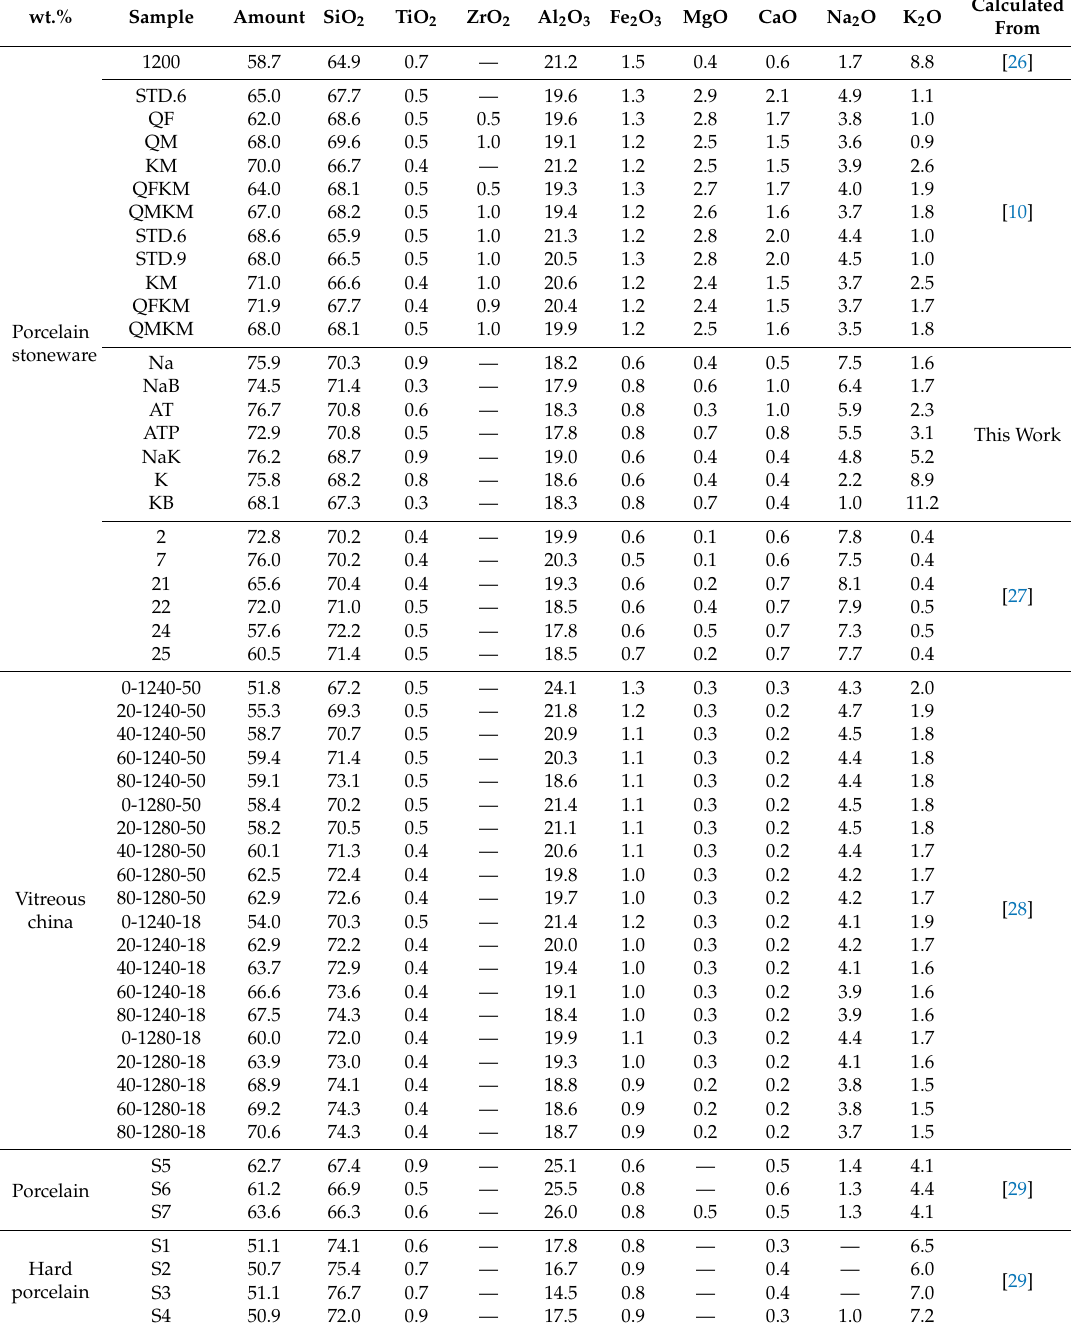
Table 1. Amount and chemical composition of the vitreous phase in porcelain-like bodies.